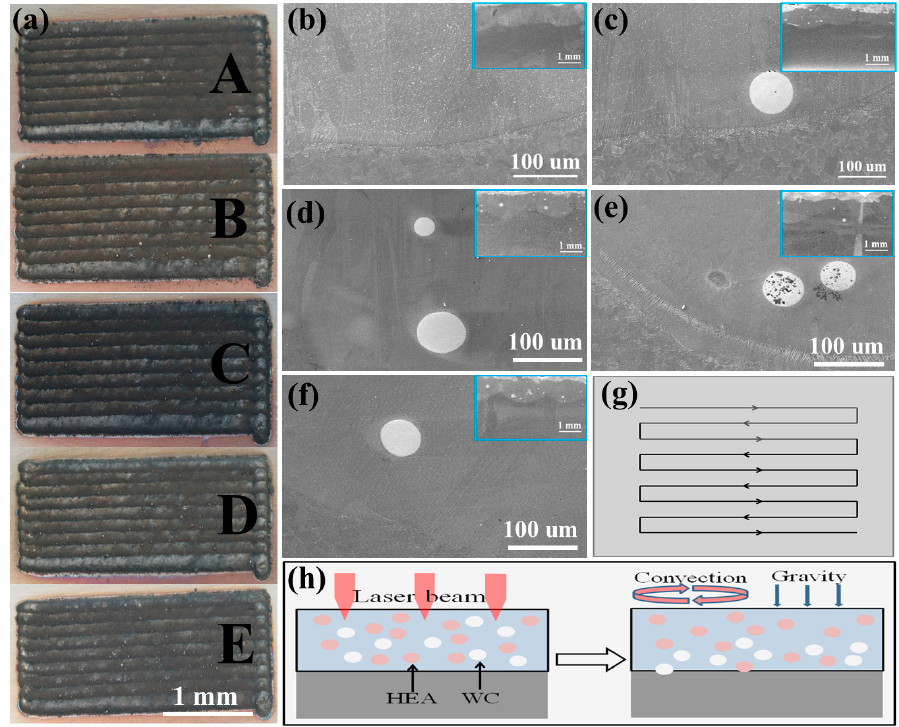
Figure 2. Morphology of HEA/WC coating. ( a ) HEA/WC coating surface; ( b ) A coating section; ( c ) B coating section; ( d ) C coating section; ( e ) D coating section; ( f ) E coating section; ( g ) scanning path diagram; ( h ) convection and gravity model of HEA/WC coating during solidi fi cation.